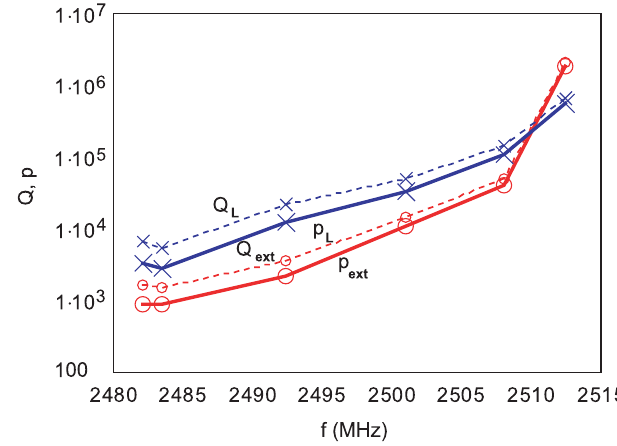
FIG. 21. (Color) Q ext and BBU parameter p [ Ohm = cm 2 = GHz ] for the cavity optimized for minimum losses, before HOM